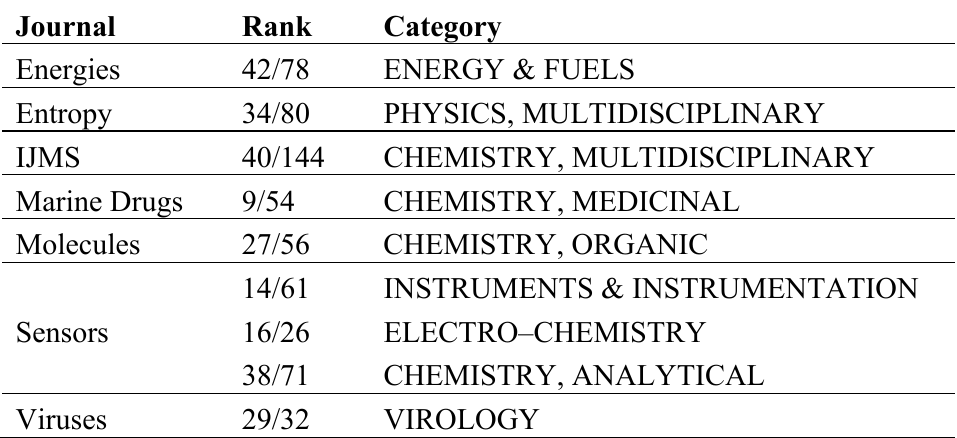
Table 2. Rankings of MDPI open access journals by subject